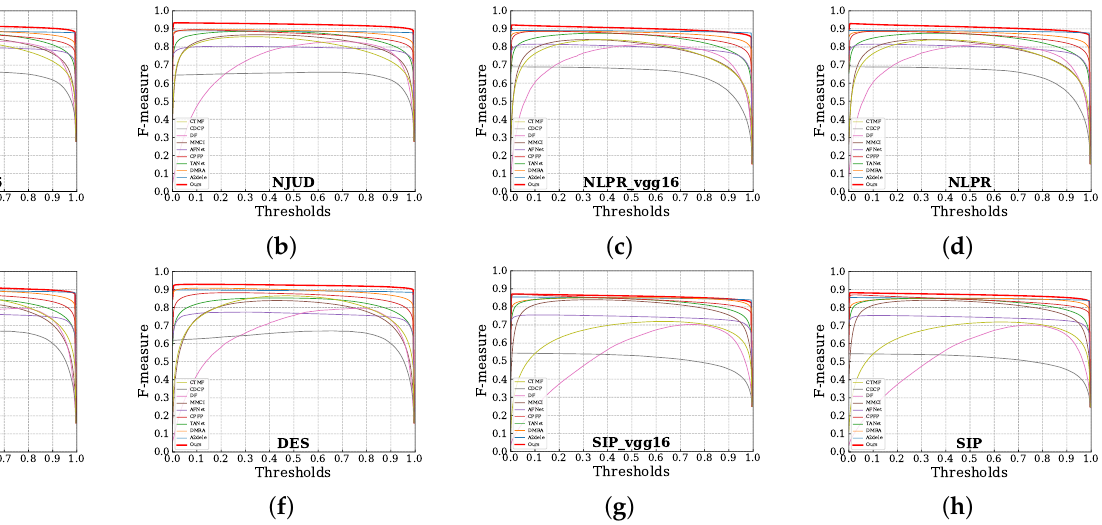
Figure 5. F-measure curves across four benchmarks on VGG16 and VGG19-based FPN. Qualitative Evaluation. Figure 6 exhibits the visual comparisons with prevalent methods in recent years. Images contain diverse objects and scenarios, which are picked from different testing datasets. It can be observed that the saliency maps generated by our method are closer to the ground truth. More specifically, row 1 shows the case where the depth image has low contrast especially on the bottom part and row 2 and 3 show complex backgrounds in the RGB images. Under these circumstances, our method generates better saliency maps with less distortion and irrelevant objects compared to other methods. Table 1. Quantitative comparisons through the maximum of F -score F β , S-score S α , E-score E θ , and error-score M , over five widely evaluated datasets. ↑ and ↓ indicate that larger and smaller scores are better. Ours and Ours* indicate simple VGG16-based and VGG19-based FPN repsectively. ite refers to the training